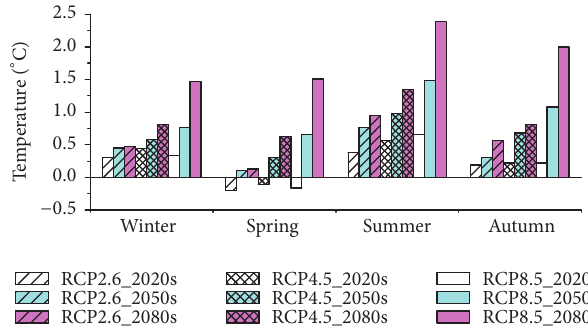
Figure 5: Mean seasonal changes in projected temperature with respect to the base period under three scenarios.